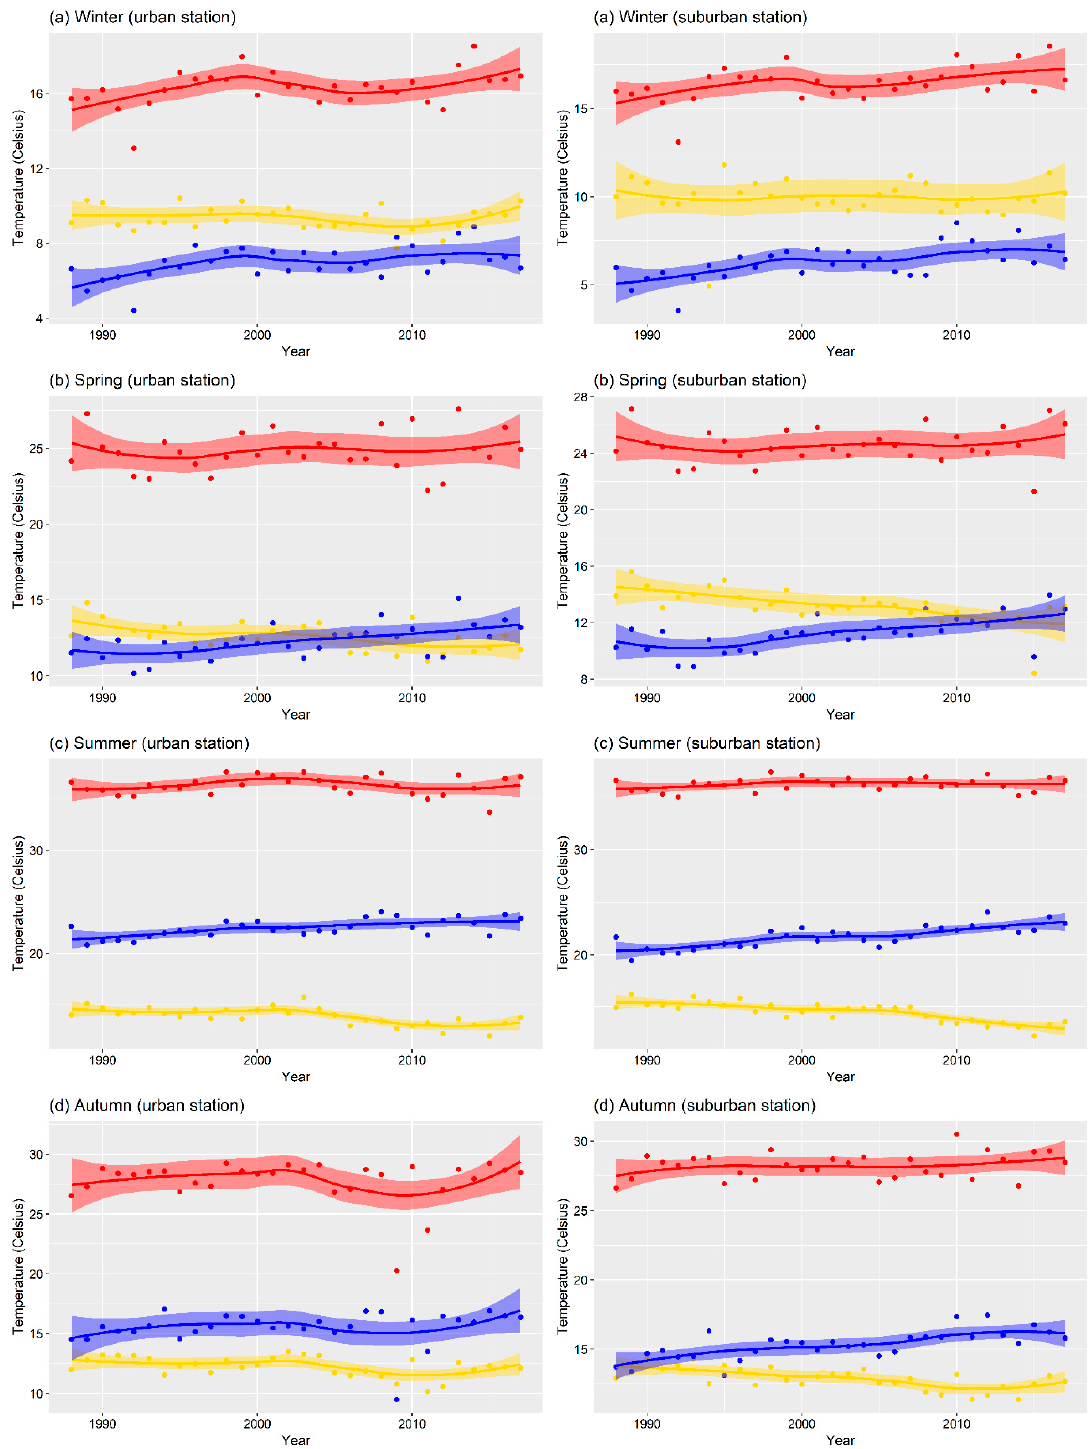
Figure 1. Mean seasonal value of DTR (yellow dots), daily maximum temperature (red dots), and daily minimum temperature (blue dots) along with the confidence intervals (95%) and loess line for the years 1988–2017 for Nicosia’s urban station (first column) and Nicosia’s suburban station (second column).